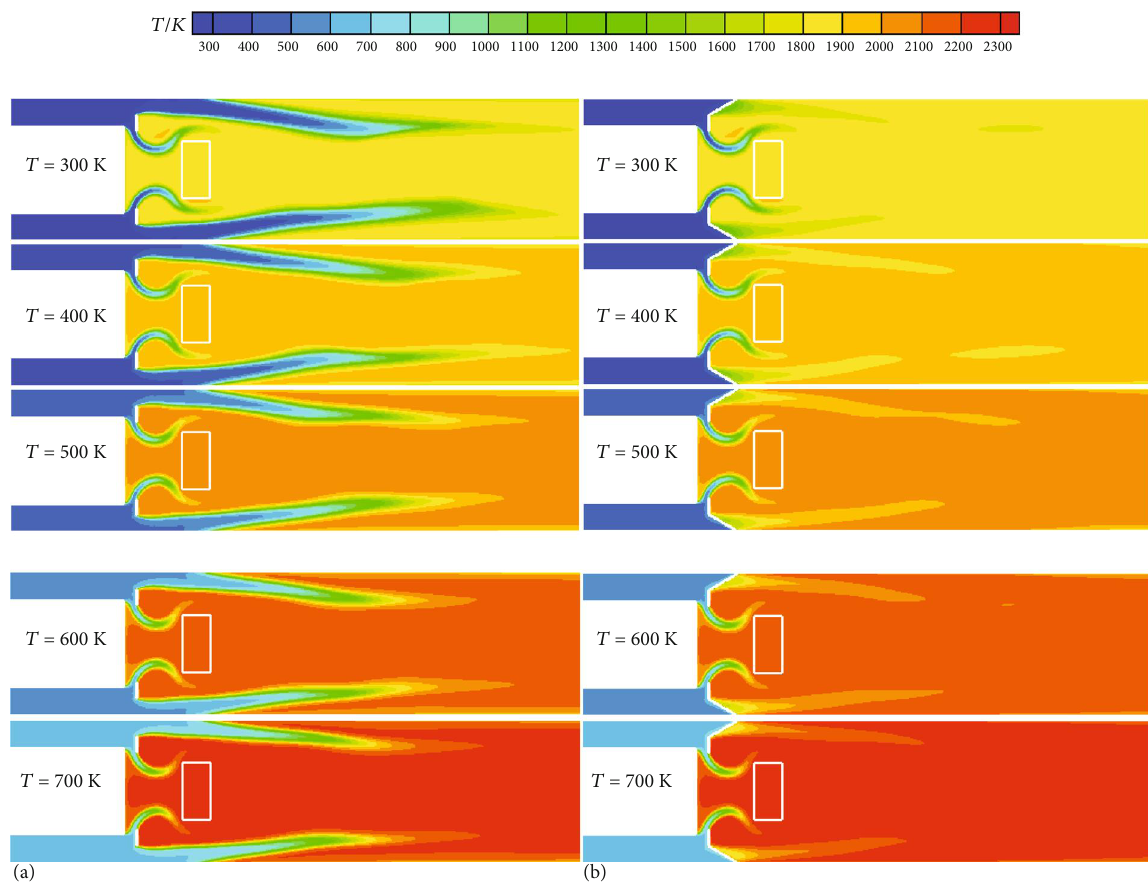
Figure 29: Temperature fi eld under di ff erent inlet temperatures.